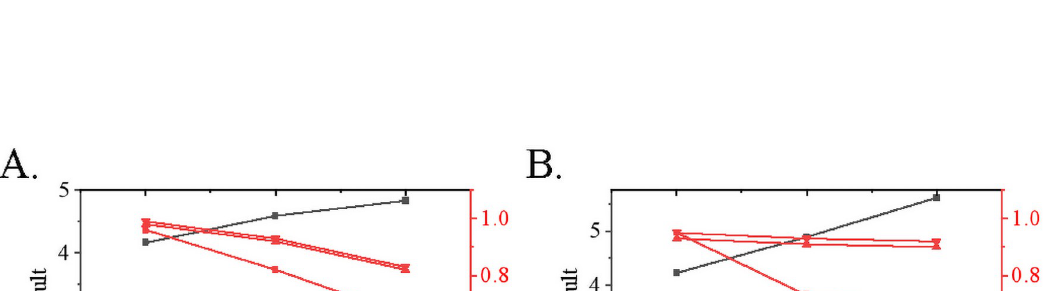
PLOS ONE | https://doi.org/10.1371/journal.pone.0257582 October 6,